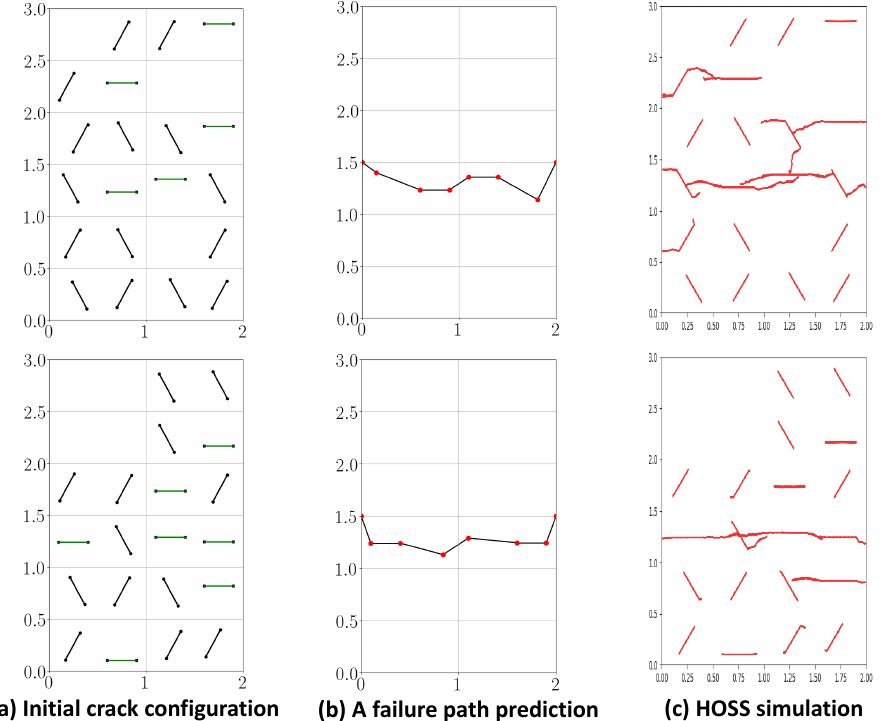
Figure 6. Failure path prediction (best scenarios, one failure path exact match): The above set of figures show the prediction of failure paths with exact match to the HOSS results. The left set of figures provide the initial crack configuration. The middle set of figures provide the prediction by the proposed method. The right set of figures show the HOSS results at